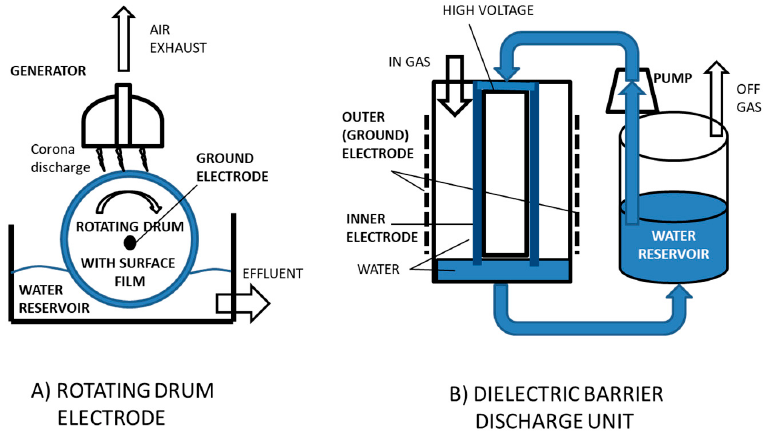
Figure 3. ( A ) Rotating drum film, corona discharge NTP unit ( B ) DBD unit with falling film. dielectric barrier discharges